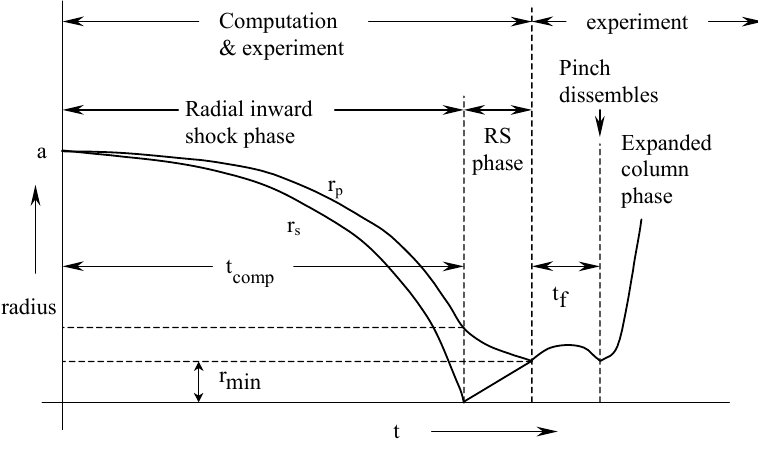
leading to the start of the p